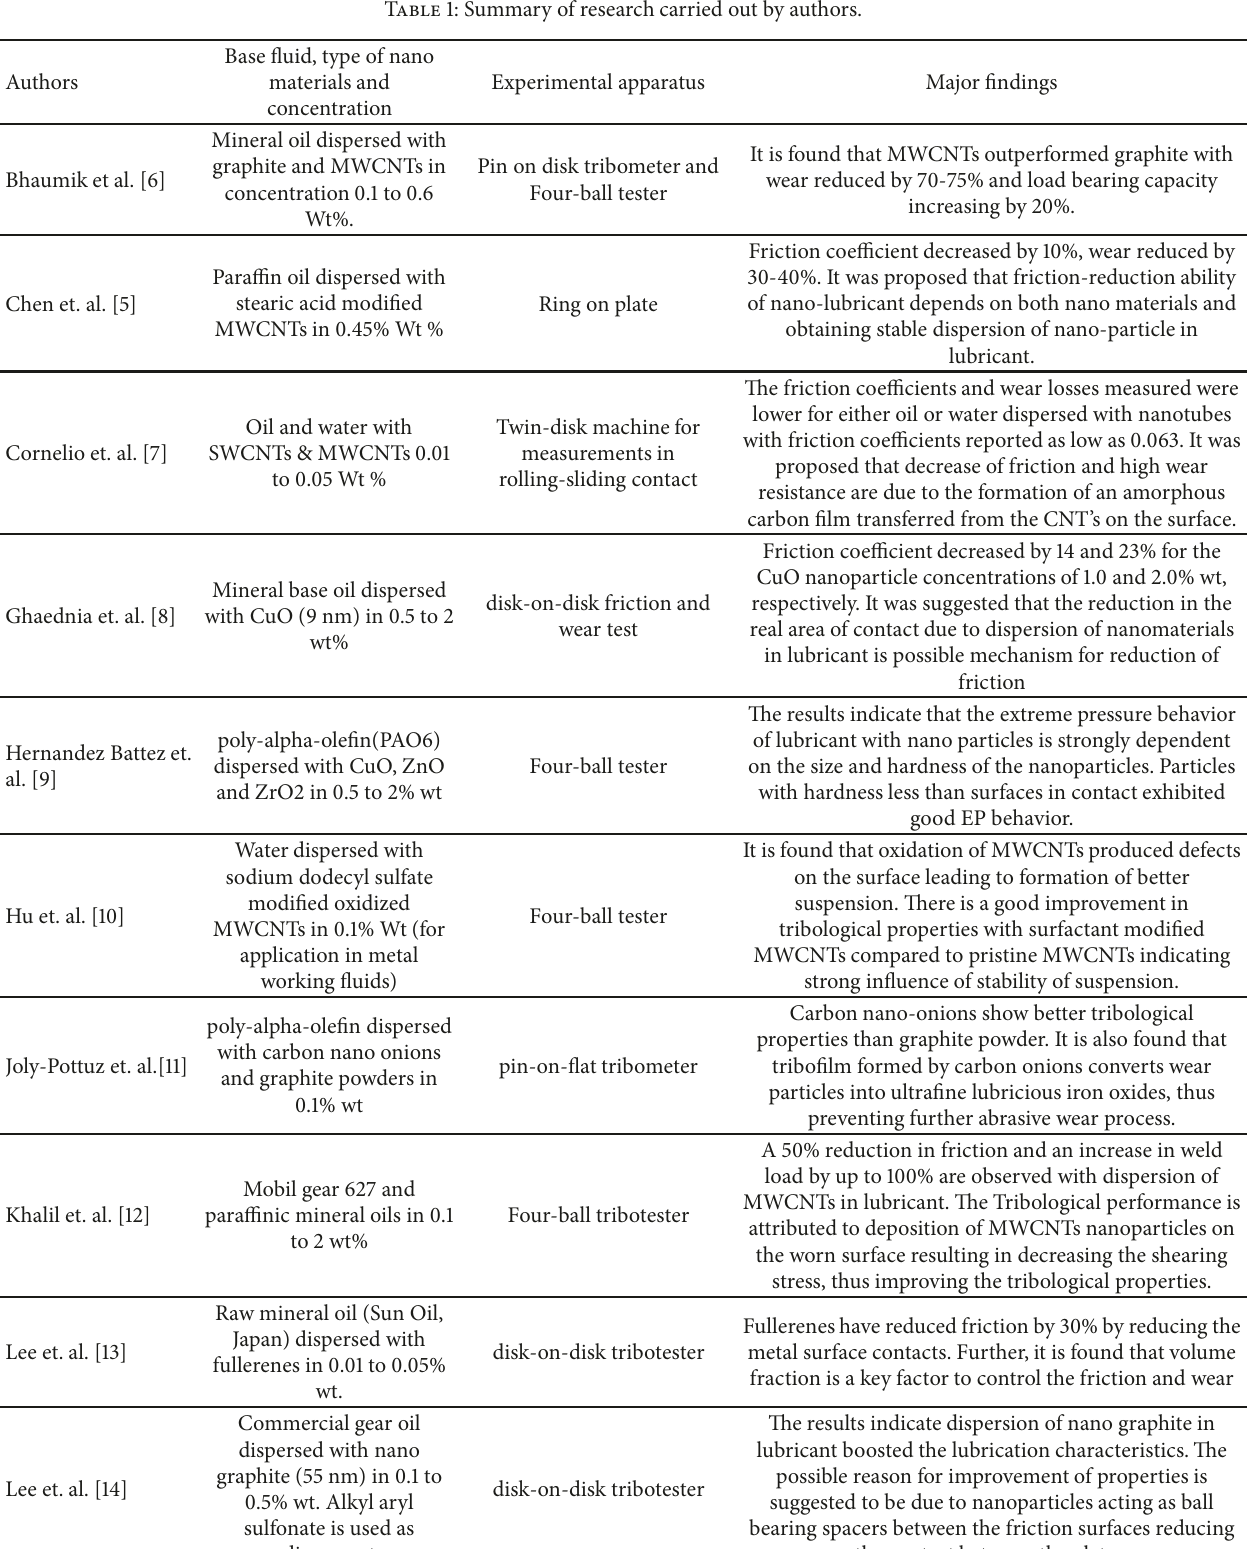
Table 1: Summary of research carried out by